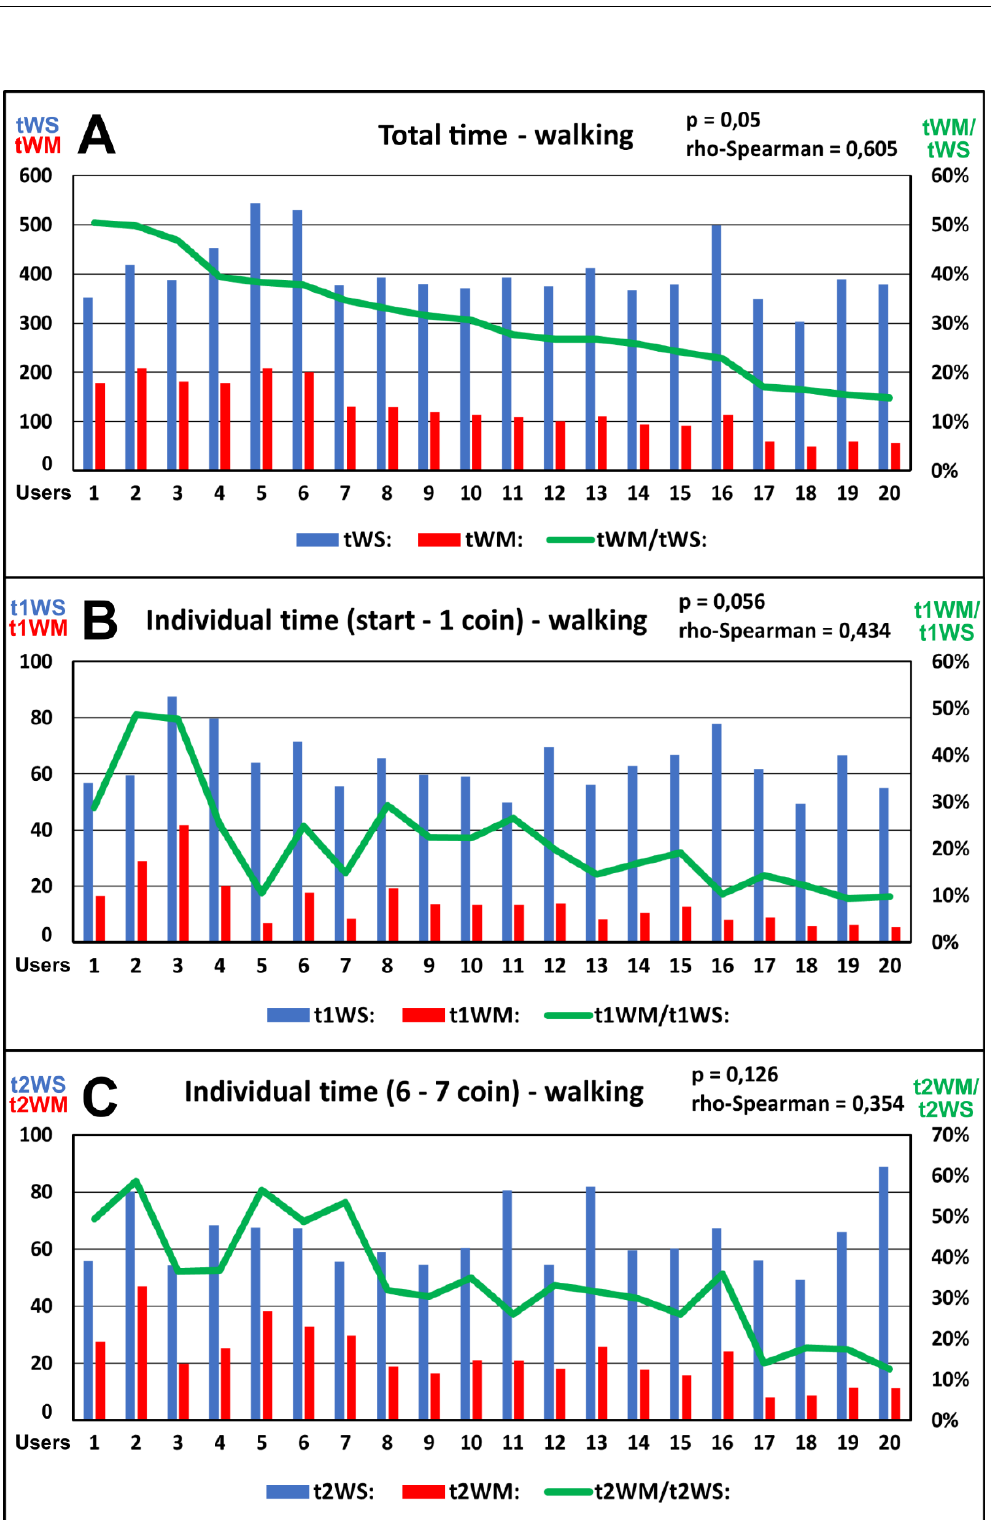
Figure 6. Visualization of time data for walking.